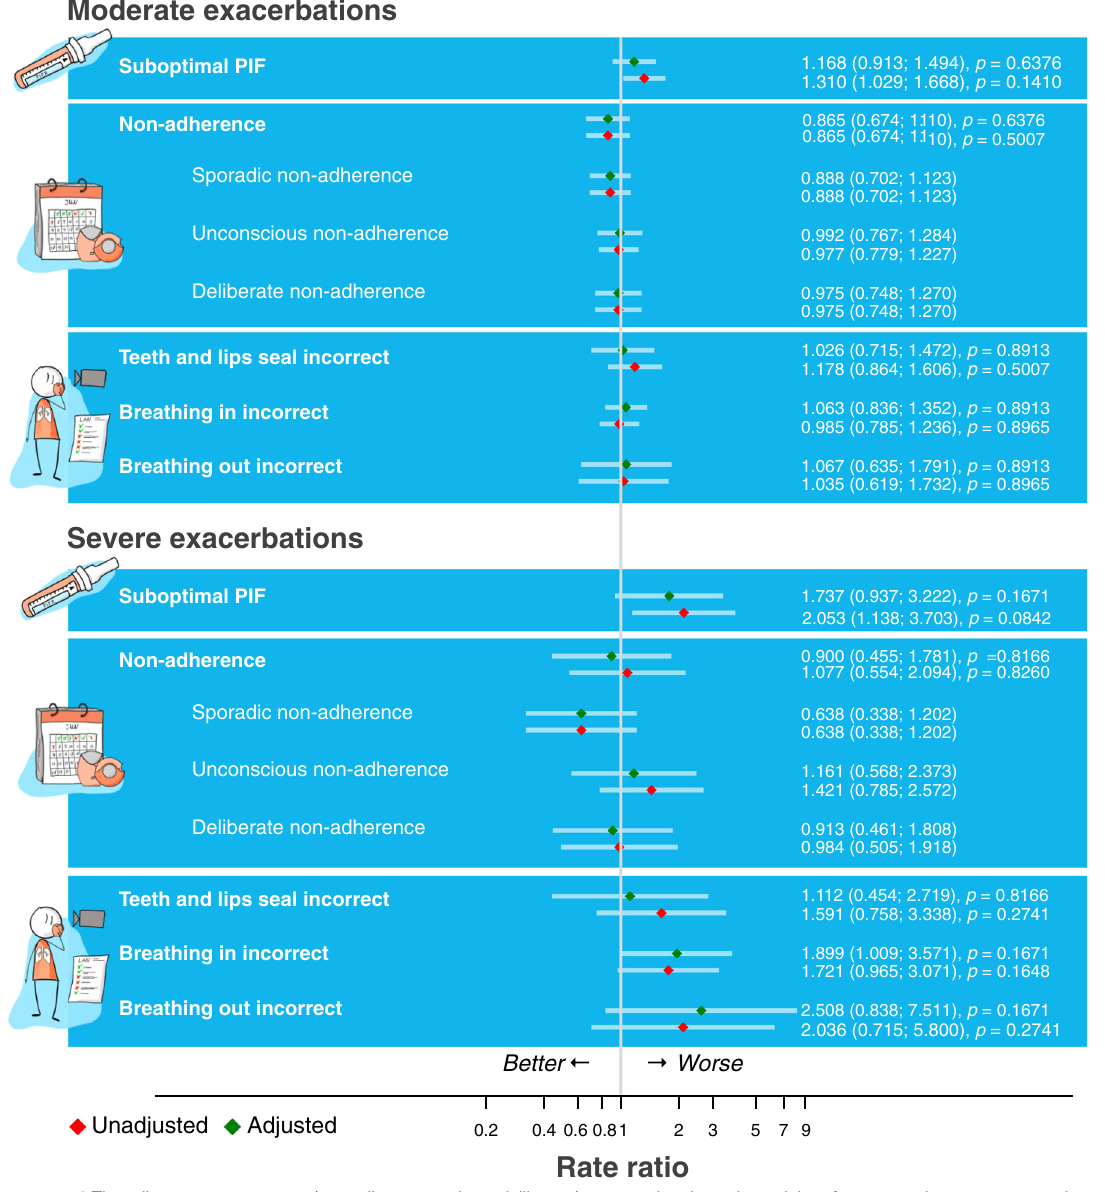
Fig. 5 Factors associated with exacerbations. Associations between PIF, inhalation errors, adherence and moderate or severe